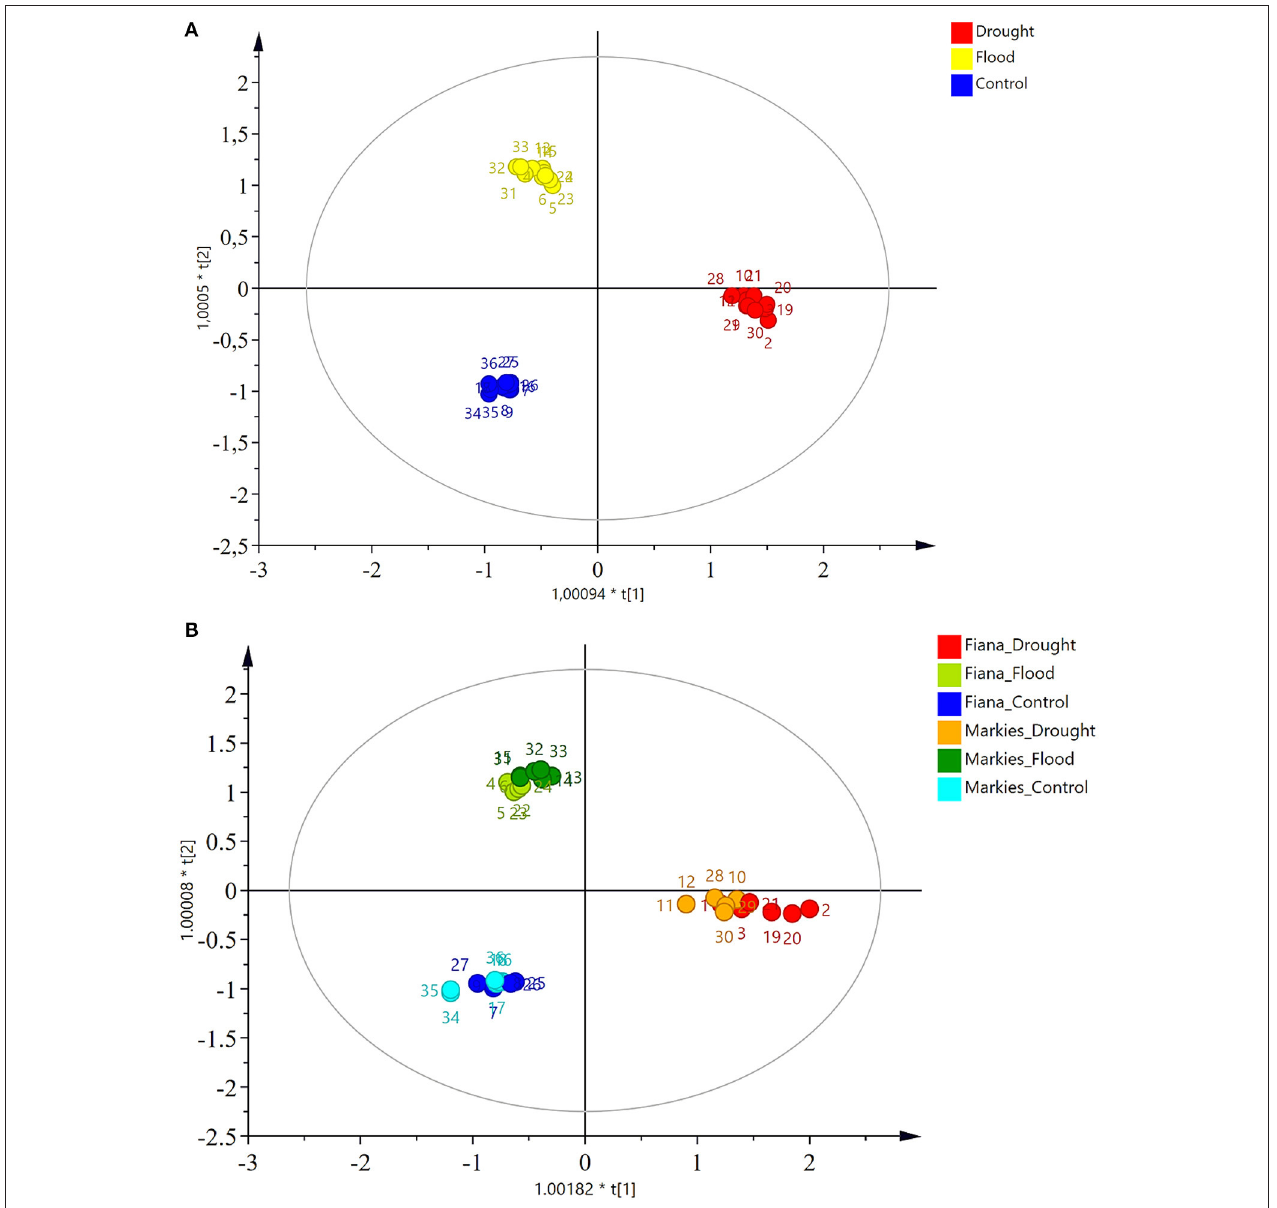
FIGURE 3 | (A) Score plot of OPLS-DA of Fianna and Markies potato cultivars and treated with control, flooding, or drought irrigation. (B) Score plot of OPLS-DA of Fianna CV showed a clear separation between the treatments of control, flooding, or drought irrigation, this analysis was repeated using Markies